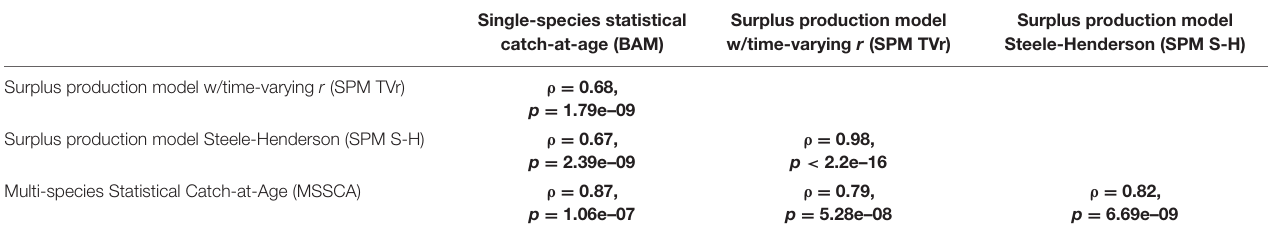
Single-species statistical Surplus production model catch-at-age (BAM) w/time-varying r (SPM